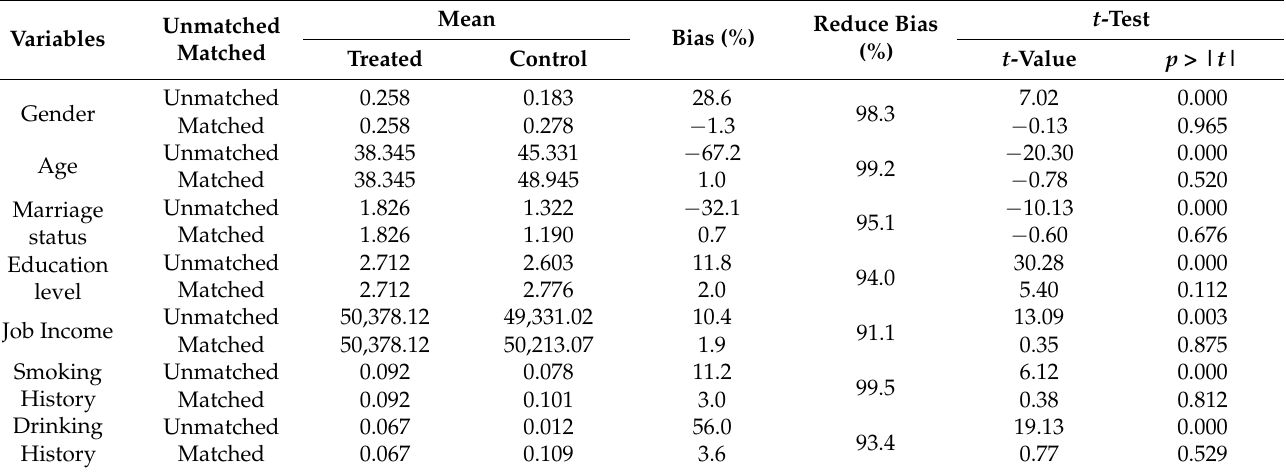
Table 6. Sample matching quality balance